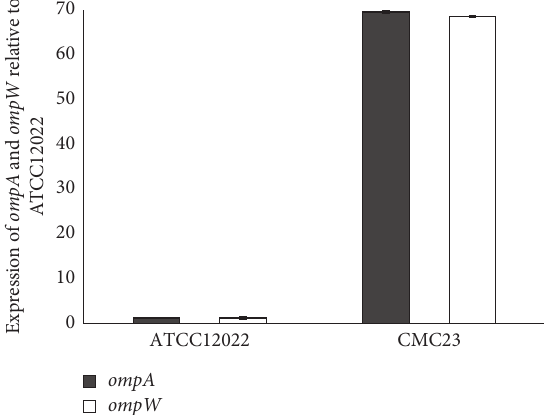
Figure 2: Relative expression of ompA and ompW genes by qRT- PCR. The relative expression level after being normalized to the expression of the reference gene 16S rRNA was compared relative to that in S. flexneri ATCC 12022. Results shown are the mean ± std of two independent experiments.